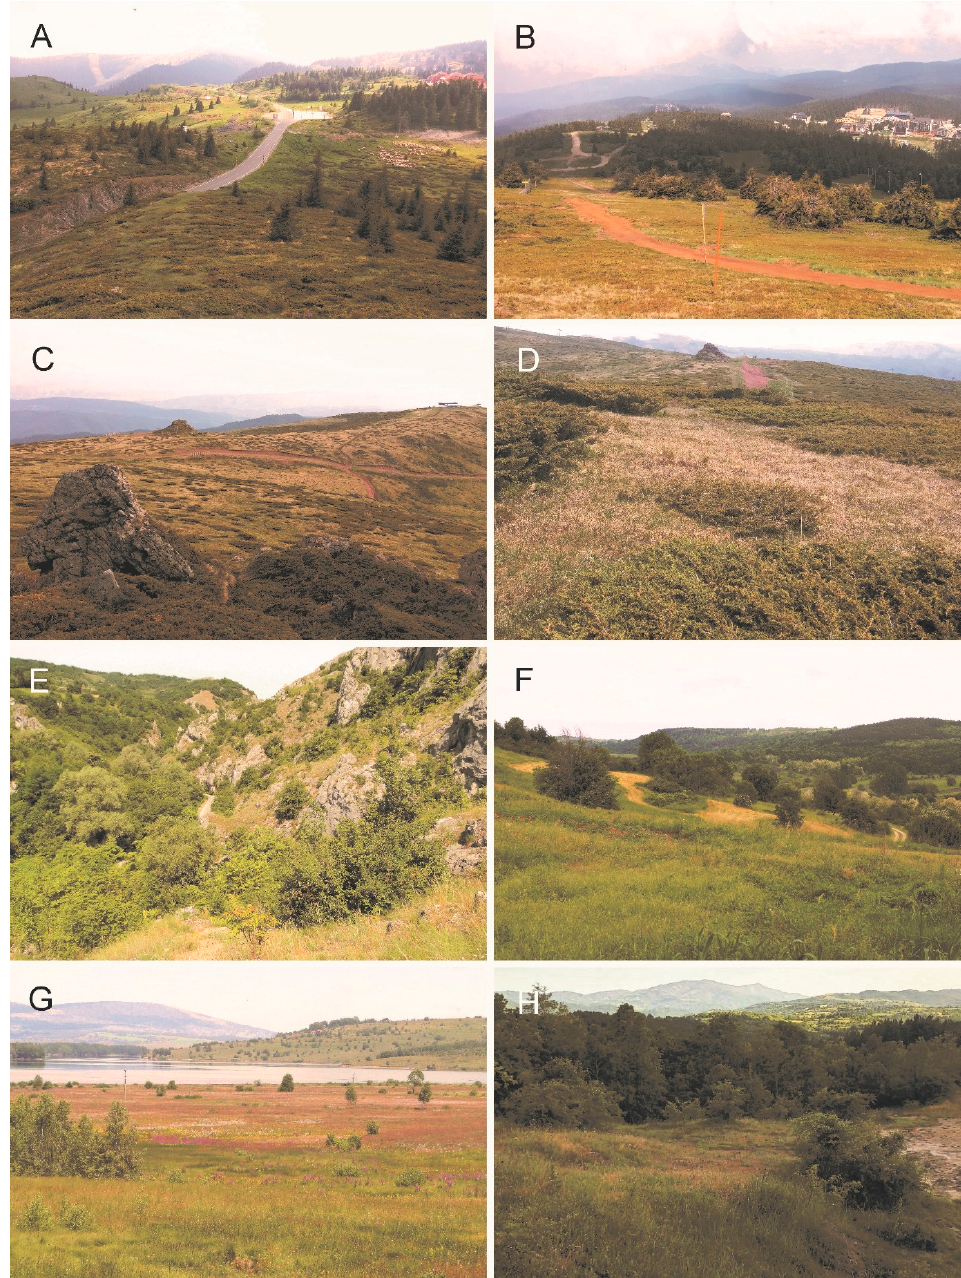
Figure 3. Collection localities of the scarabaeoid beetles in Serbia (2013, 2017–2019, 2021, 2022): ( A )—Brze ć e at Brus, ( B )—Kopaonik at Raška, ( C,D )—Zaskovci at Pirot, ( E )— Č ukljenik at Niška Banja, ( F )—Ivanje at Bojnik, ( G )—Damnjani č ovi at Surdulica, ( H )—Vladovce at Trgovište (Photos: ( A – D )—Tomasz Gazurek, ( E – G )—Dawid Marczak and ( H )—Marek Bidas).